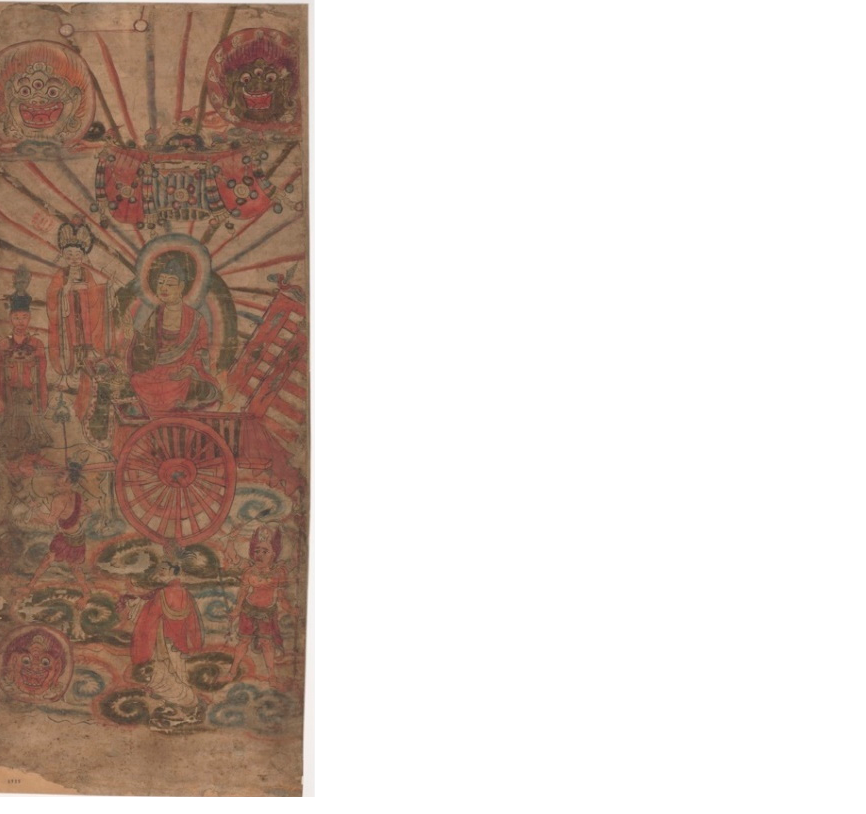
Figure 3. Tejaprabh ā procession, ca. 10th century, ink and colors on paper. 30.5 cm × 76.4 cm, Mogao